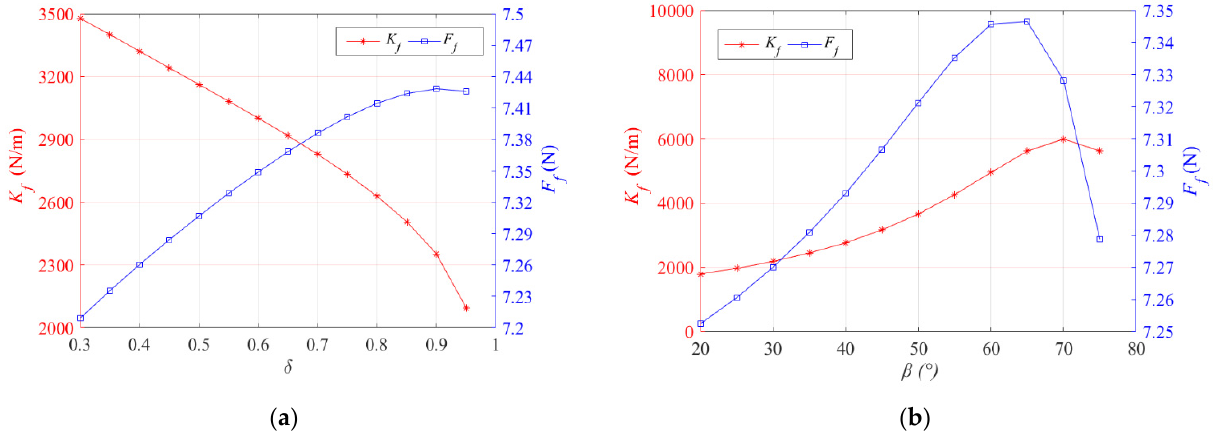
Figure 14. Influence of the groove width ratio and spiral angle on the stiffness and hydrodynamic force: ( a ) Groove width ratio; ( b ) Spiral angle.